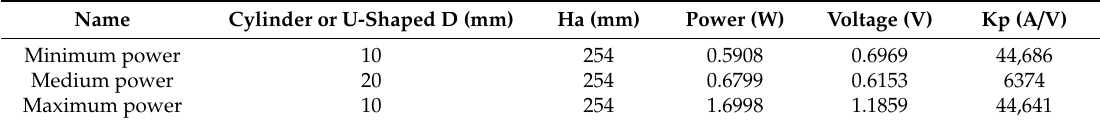
Table 4. Summary of the energy harvester characteristics.